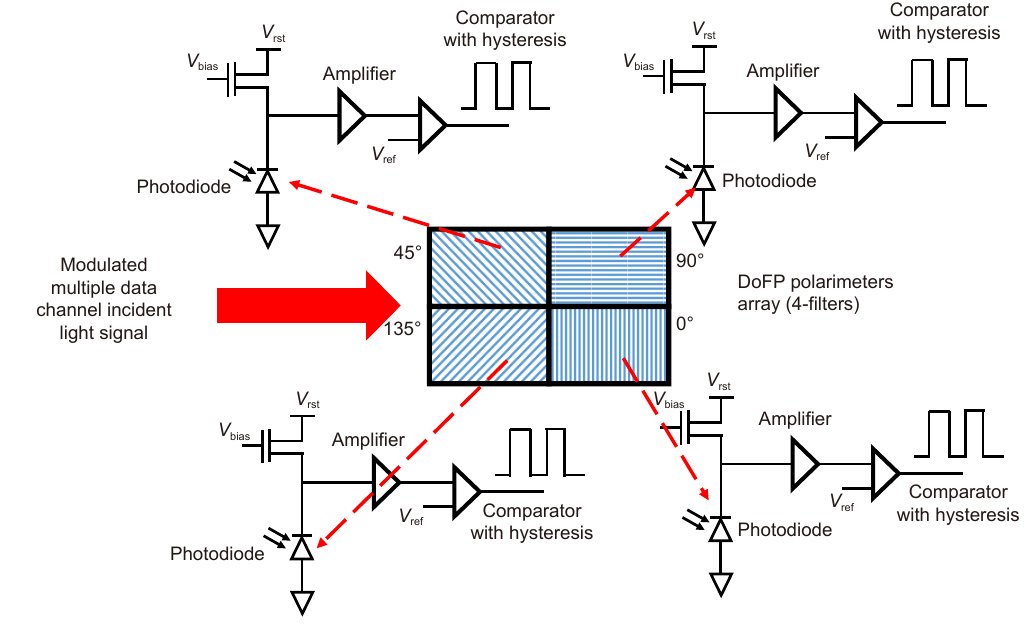
Fig. 6 | 4-channel VLC network. Figure reproduced from ref. 57 ,